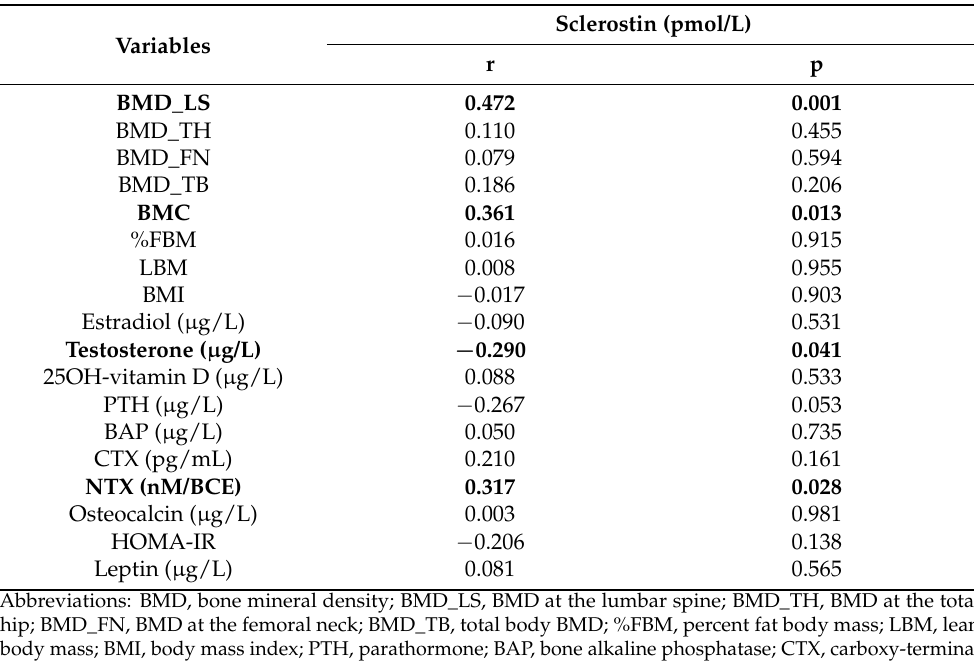
Table 4. Bivariate correlation analysis between sclerostin levels and the main variables of interest in the groups as a whole. Pearson’s correlation coefficient and 2-tailed significance are shown for each variable, with significant associations in bold.